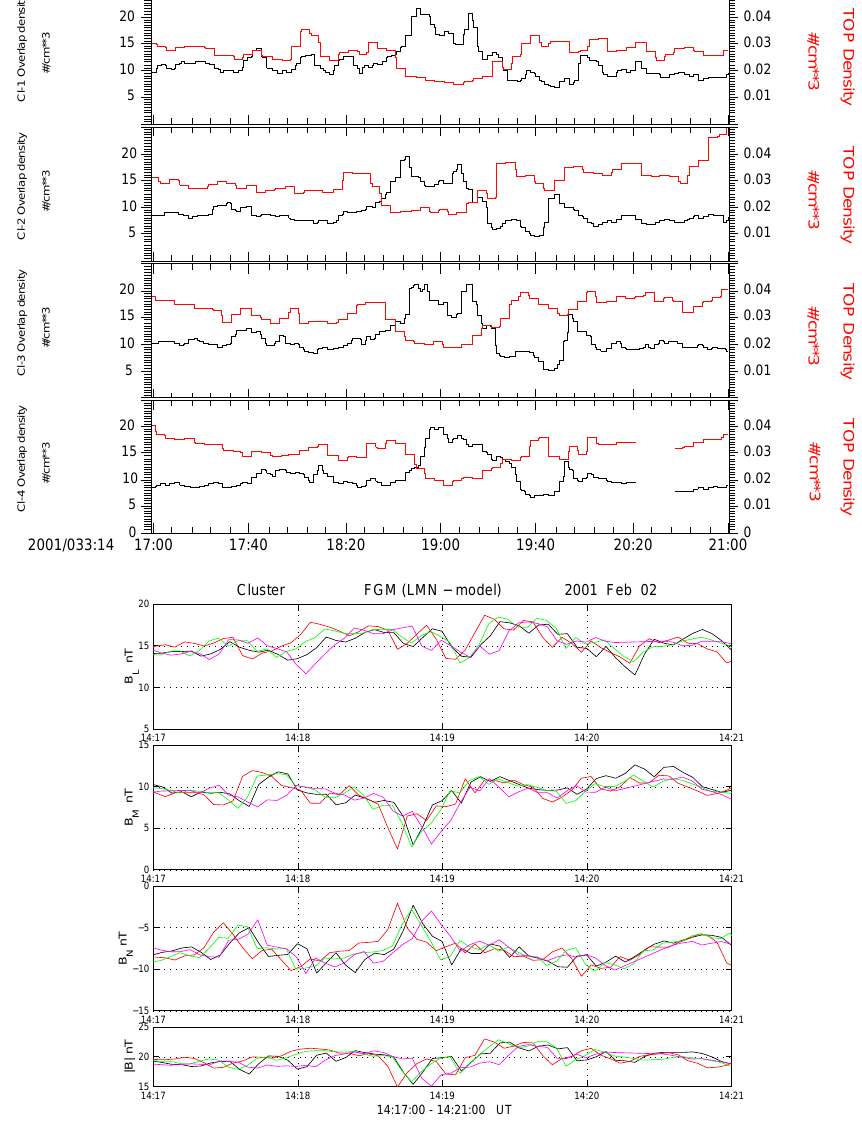
Fig. 7. As Fig. 5, for the period from 14:17–14:21 UT. (a) Enhancements in the density of magnetosheath-like electrons are observed at all 4 spacecraft approximately centred on 14:19 UT. Brief enhancements in the magnetospheric electrons are seen both before and after this magnetosheath electron population, with a dropout in between. A second, less dense population of magnetosheath electrons is observed at all 4 spacecraft in the period from 14:19:40–14:20:00 UT. (b) The magnetic field components and field strength for this period. The B N component again shows a bipolar signature, with a brief positive deflection followed by a more extended negative